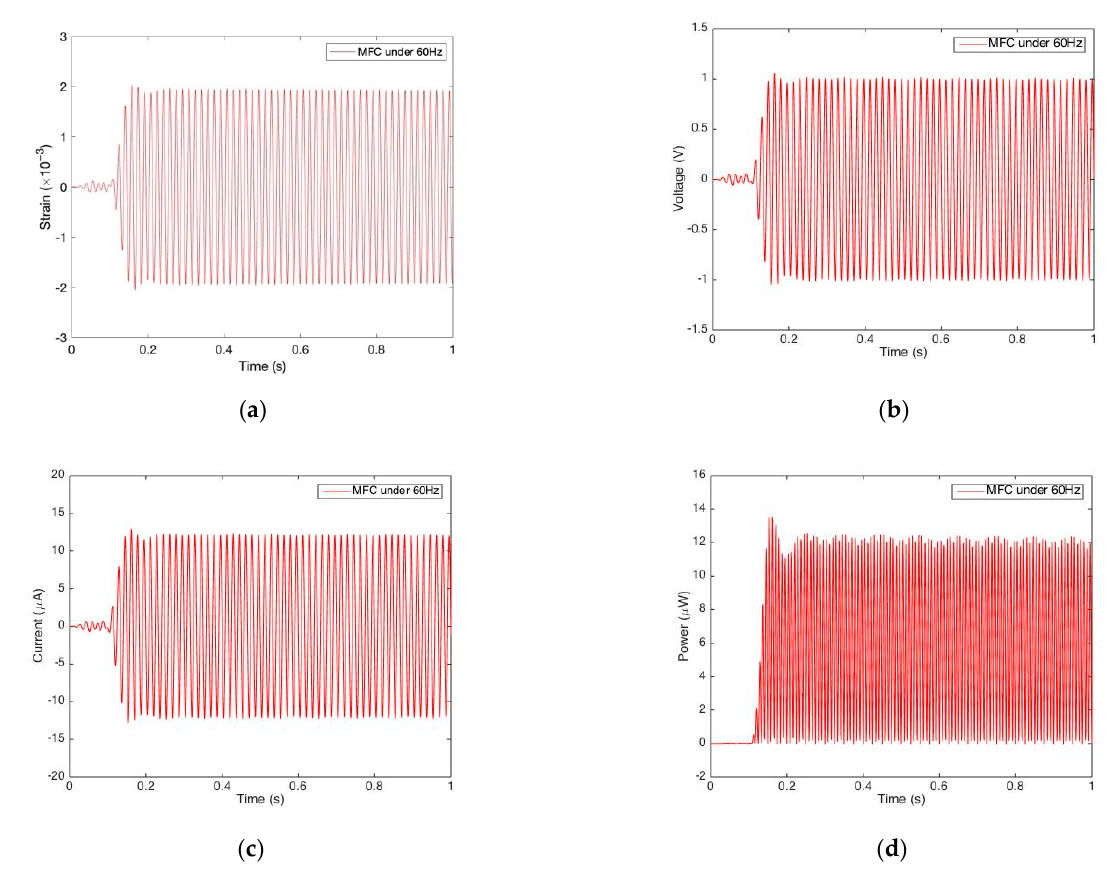
Figure 5. Mechanical and electric responses from MFC under resonant excitation. ( a ) Strain response for MFC under 60 Hz; ( b ) Voltage response for MFC under 60 Hz; ( c ) Current response for MFC under 60 Hz; ( d ) Power response for MFC under 60 Hz.